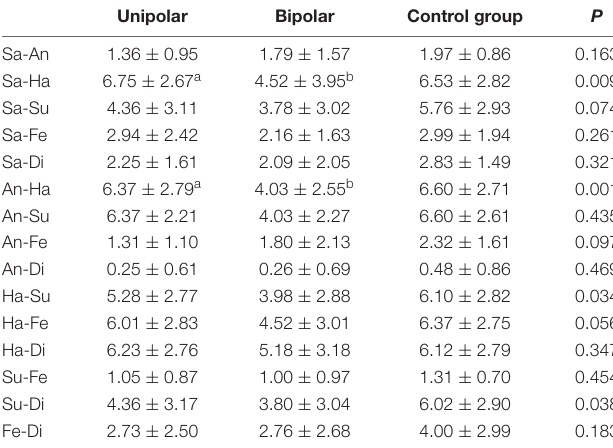
P represents the value of statistical analysis among the three groups. a represents a statistical difference between patients with UD and BD. b represents a statistical difference between patients with BD and the control